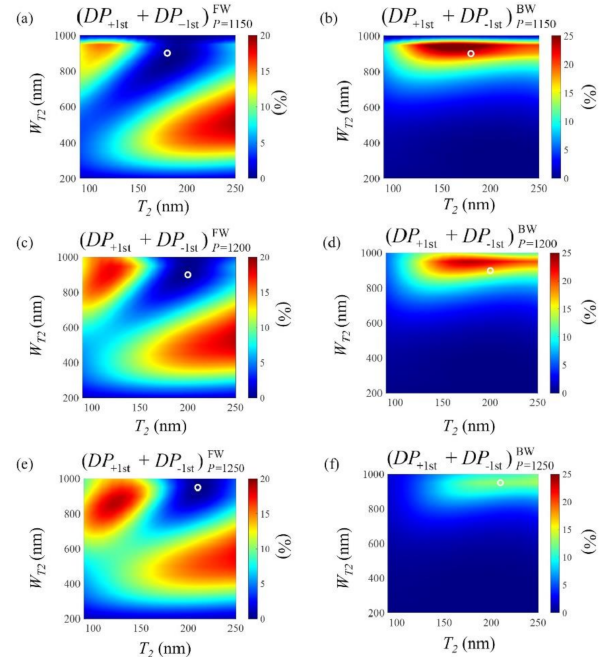
Figure 5. Various conditions for analyzing the sum of plus and minus first-order diffraction power efficiency ( DP +1st + DP − 1st ) according to the metal thickness designed for ( a , b ) P = 1150 nm, ( c , d ) P = 1200 nm, and ( e , f ) P = 1250 nm. ( a , c , e ) show color images for the forward direction, while ( b , d , f ) show those for the backward direction. The white circles indicate the optimal thickness at each P value of the proposed